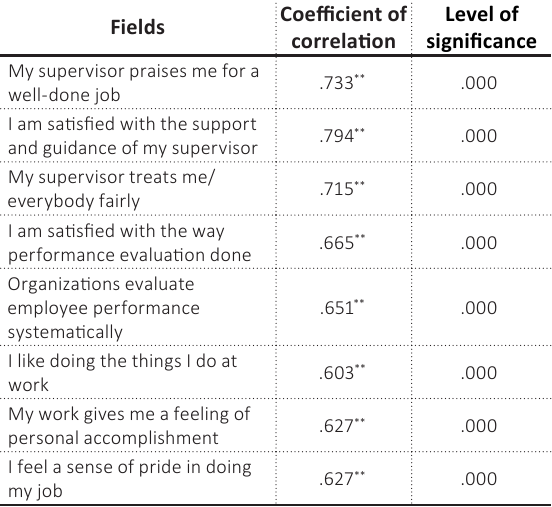
Table 5. Person correlation test for job